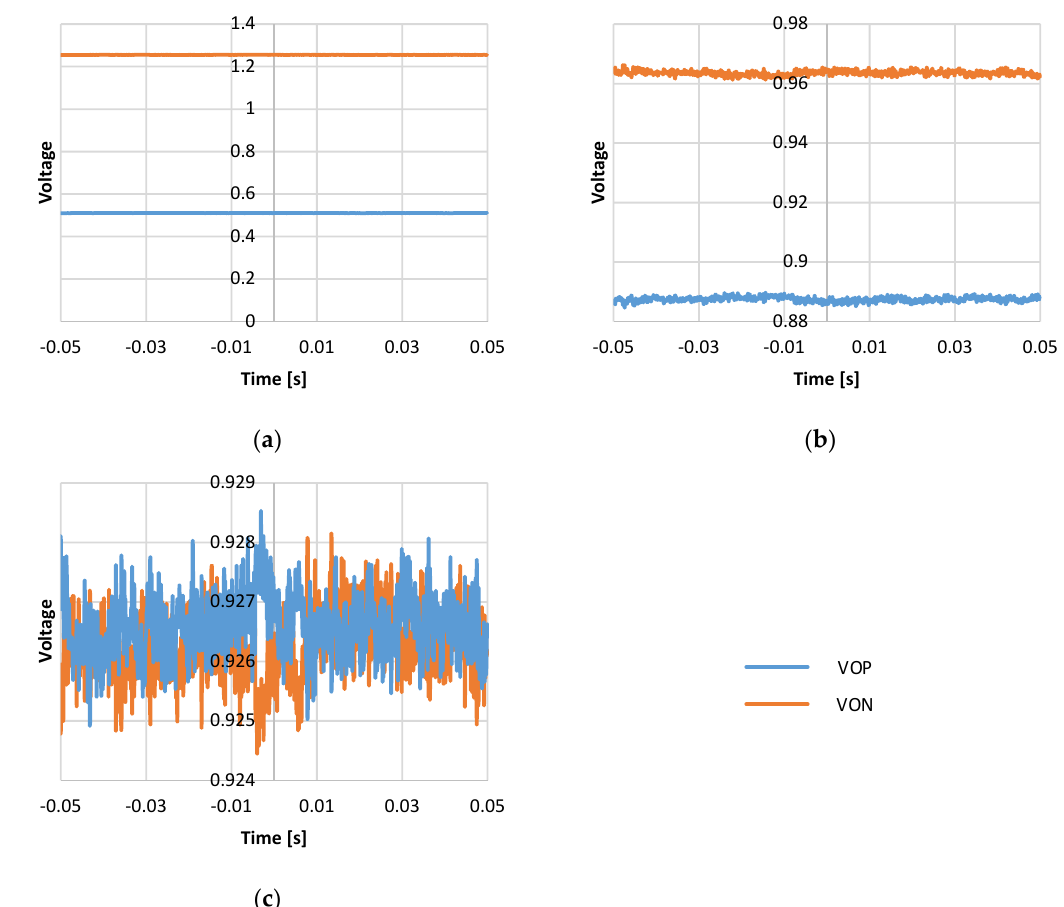
Figure 15. The output signal amplitude versus acceleration.